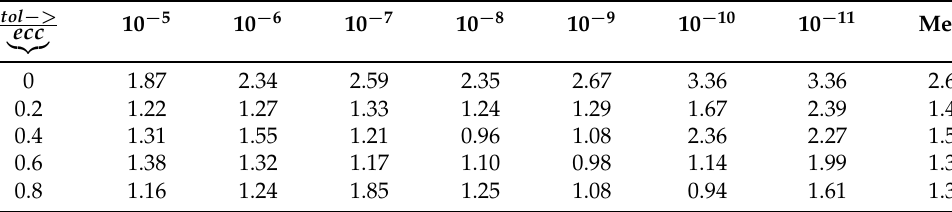
Table 4. Efficiency measure ratios of DLMP6(5) vs. NEW6(5) for Kepler in [ 0,20 π ] .